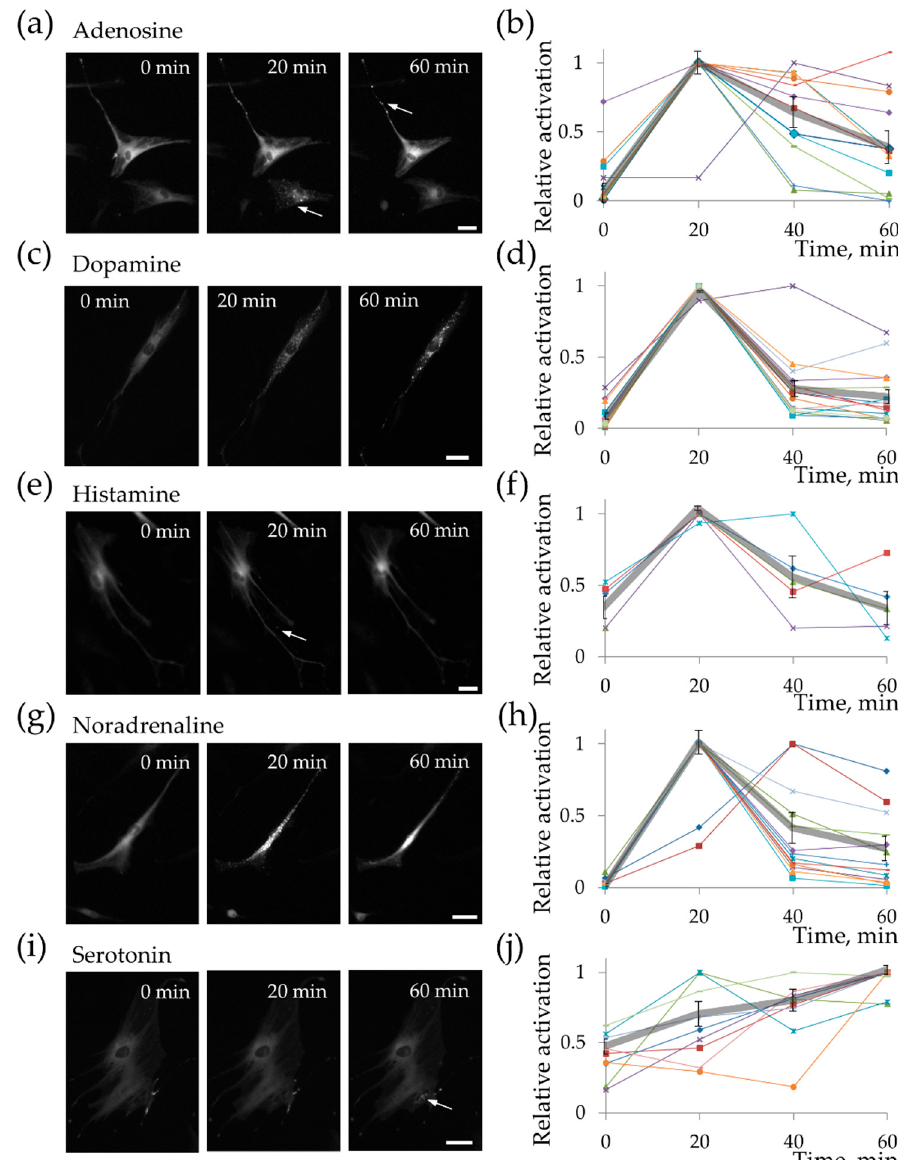
Figure 3. Hormones activated PKA with di ff erent amplitude and duration. Responses on ( a , b ) 10 − 5 M of adenosine; ( c , d ) 10 − 5 M of dopamine; ( e , f ) 10 − 6 M of histamine; ( g , h ) 10 − 6 M of noradrenaline; ( i , j ) 10 − 5 M of serotonin. Left panel shows time points of response of representative cells. Scale bar 20 µ m. Right panel shows time dynamics of responses of individual cells (colored thin lines) and corresponding mean response (thick gray line). Mean ± SE, n = 5–15 from 2 independent experiments on 2 di ff erent